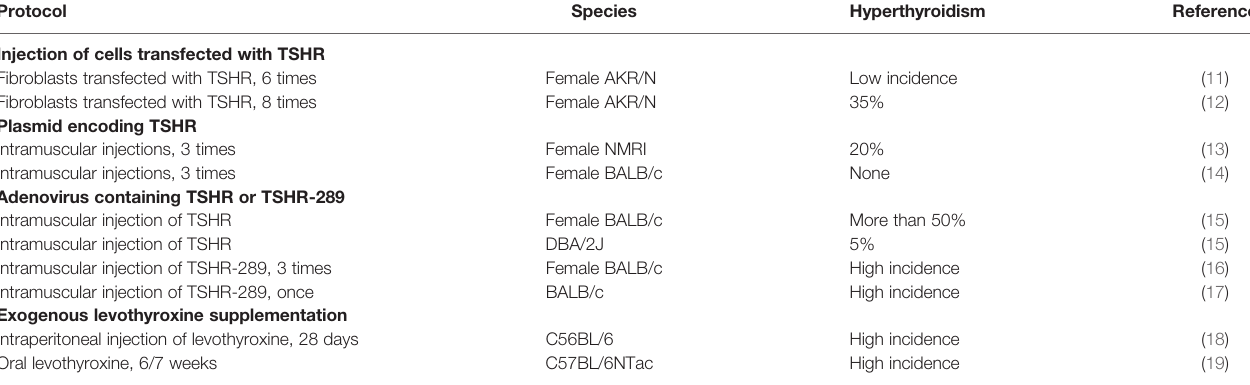
TABLE 1 | Summary of mouse models of